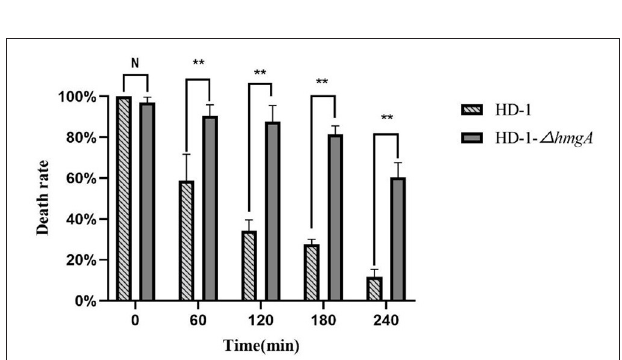
FIGURE 7 | Insecticidal lethality statistics of two strains before and after UV irradiation.